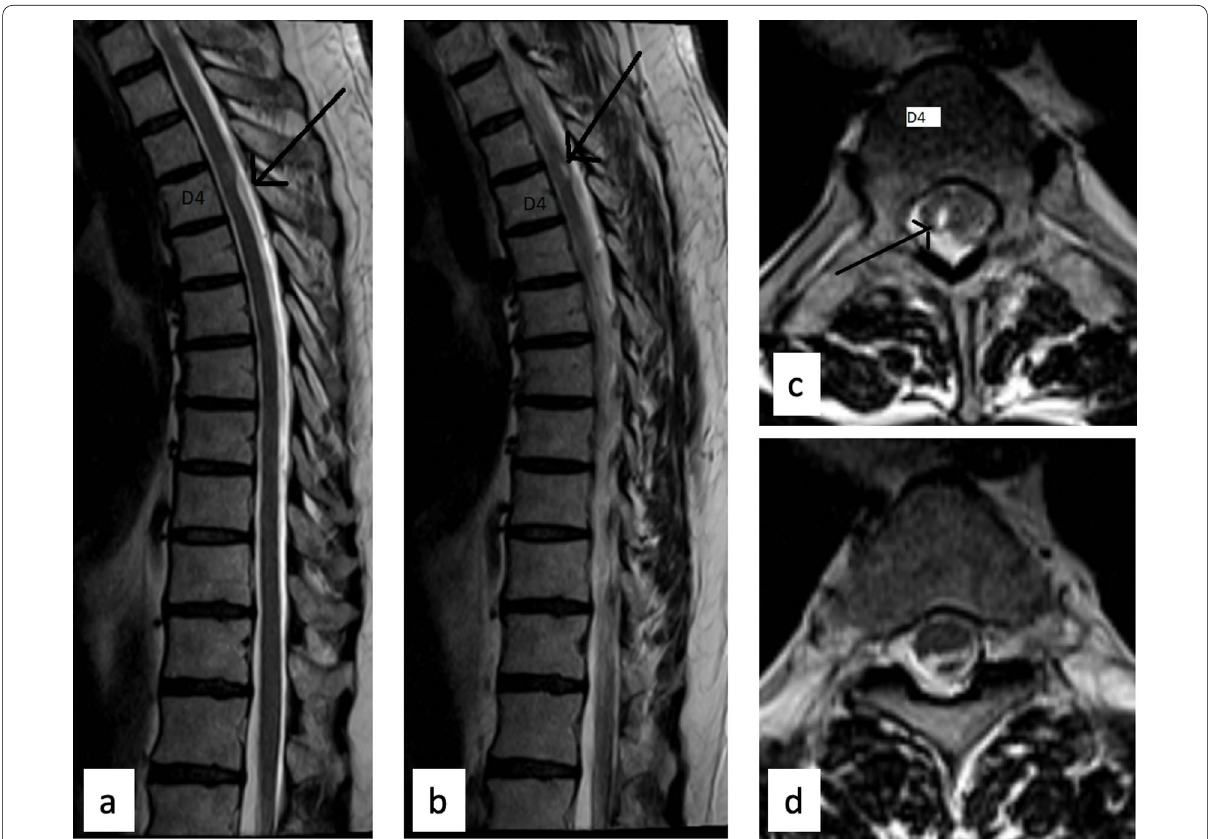
Fig. 1 MRI of the dorsal spine T2W sagittal ( a , b ) and axial ( c , d ) sections show a small syrinx within the cord at D4 vertebral level on right side (black arrow). There was sharp dorsal indentation of the cord (black arrow in a) and widening of the subarachnoid space below this level. This appearance is similar to a surgical scalpel. The anterior subarachnoid space is